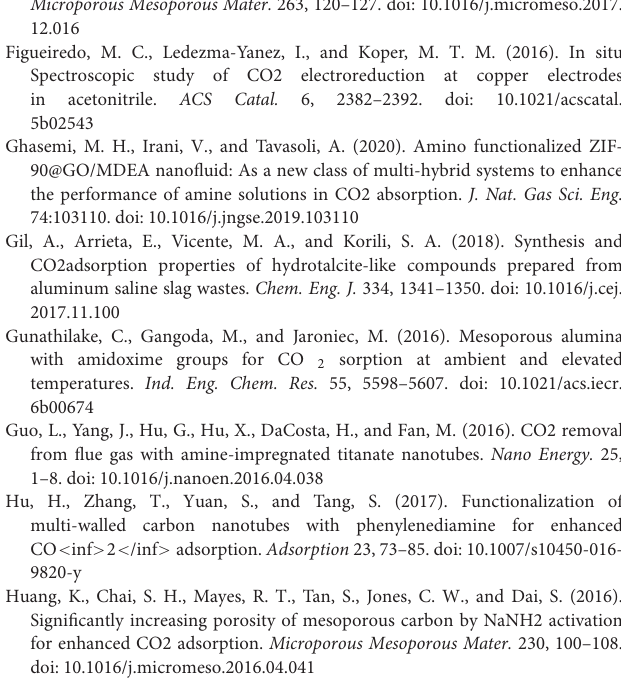
FIGURE S1 | EDS analysis of recycled multi-metal oxide prepared from the spent car catalytic converter. FIGURE S2 | EDS analysis of 60 wt.% PEI